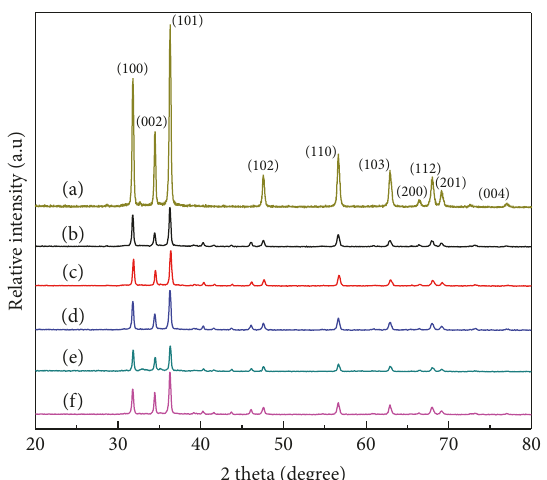
Figure 6: X-ray diffraction plot of ZnO nanostructures grown with different SDS surfactant concentrations of (a) 0 g, (b) 0.1g, (c) 0.2 g, (d) 0.3 g, (e) 0.4 g, and (f) 0.5 g.